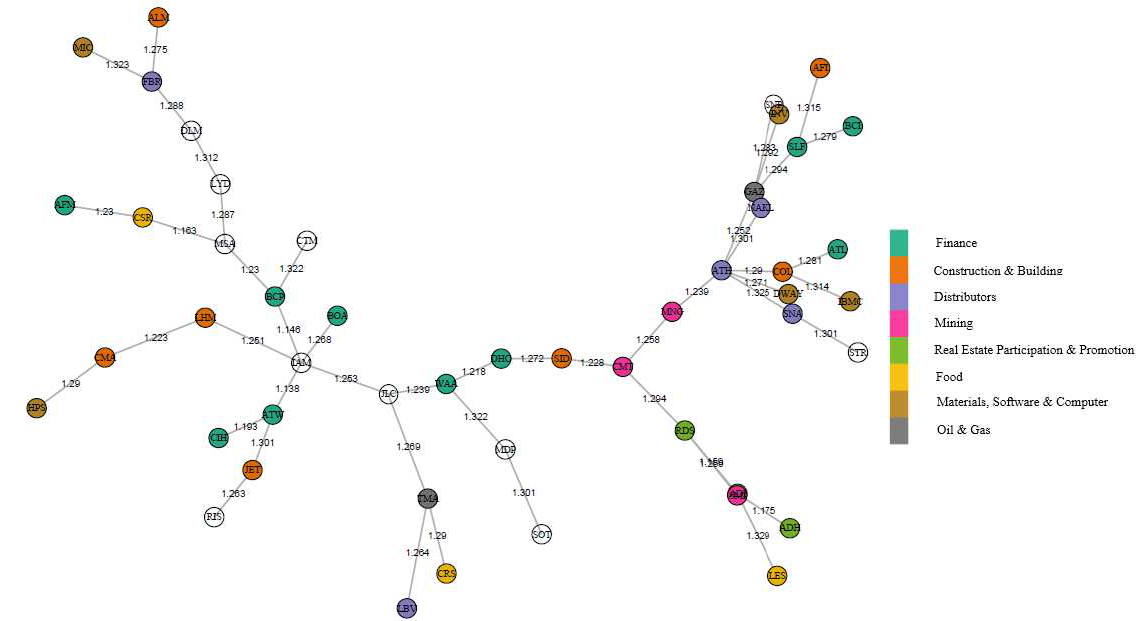
Figure 1. Before crisis minimum spanning